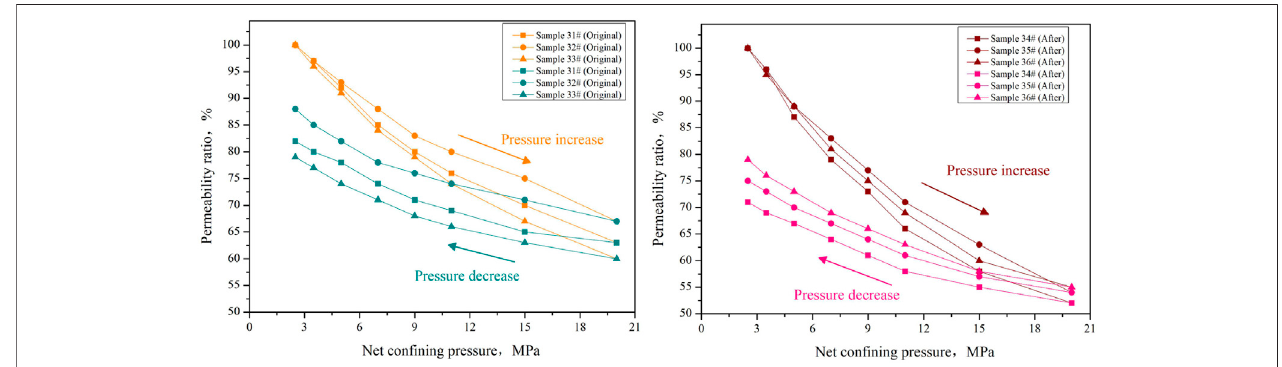
FIGURE 13 | Effect of supercritical CO 2 on stress